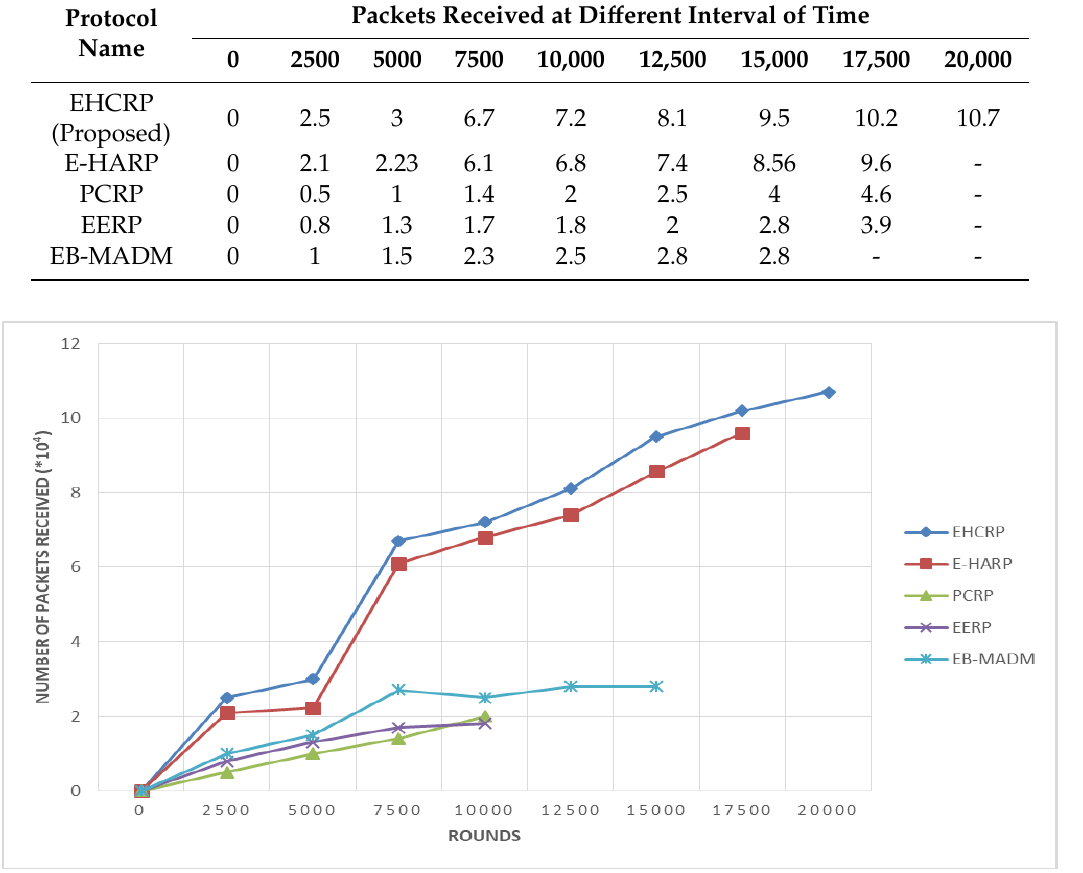
Figure 10. Breakdown of network throughput.